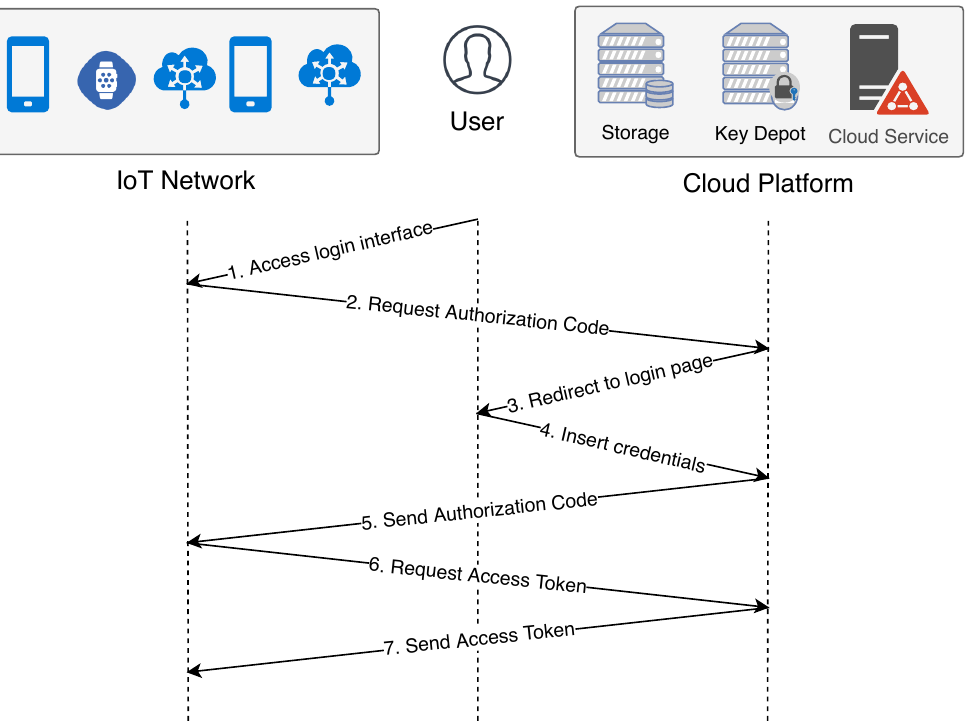
Figure 2. Binding scheme: The arrows represent the direction of communication among the IoT network, user and cloud platform. The numbers represent the order of communication and the corresponding